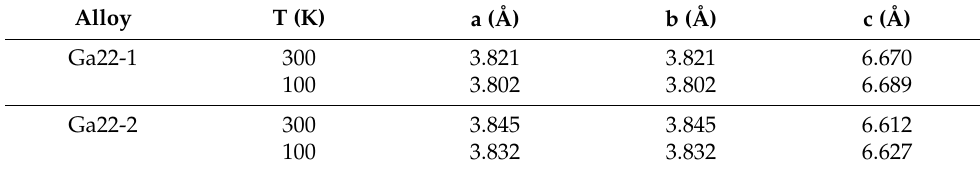
Figure 2. ( a , b ) High-energy X-ray diffraction patterns experimentally collected at 300 K and 100 K for the Ga22-1( x = 0) alloy ( a ) and Ga22-2 ( x = 2) alloy ( b ), respectively. Table 1. Lattice parameters of Ga22-1 ( x = 0) and Ga22-2 ( x = 2) alloys at 300 K and 100 K.